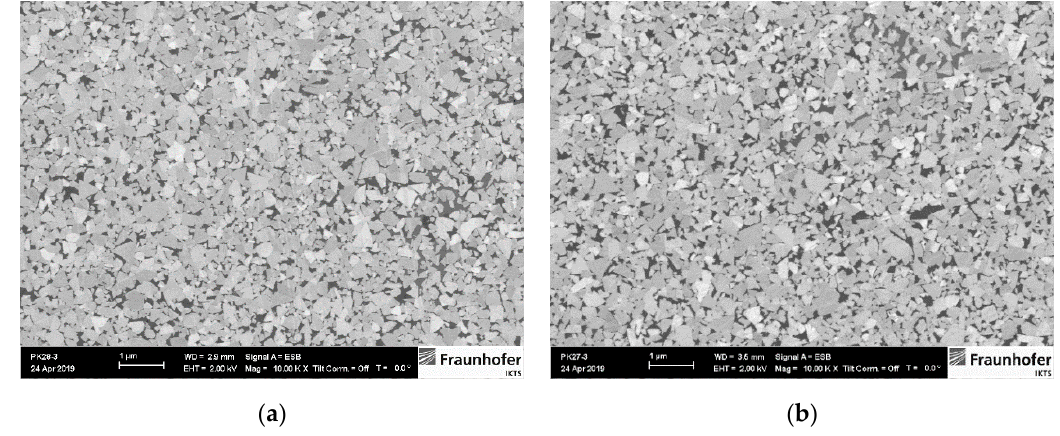
Figure 1. Microstructure of samples ( a ) WC-11 Ni-a and ( b ) WC-11 Co-c.